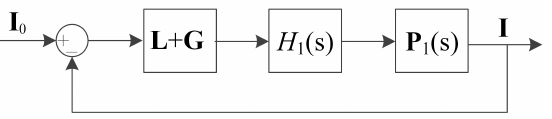
Figure 3. The control block diagram of the current